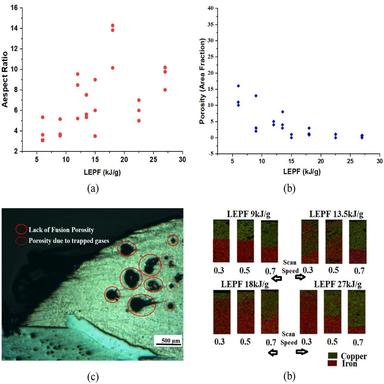
Single track analysis (a) Aspect Ratio (b) Porosity (c) Typical optical microscopy (d) EDS mapping along the track cross-section.